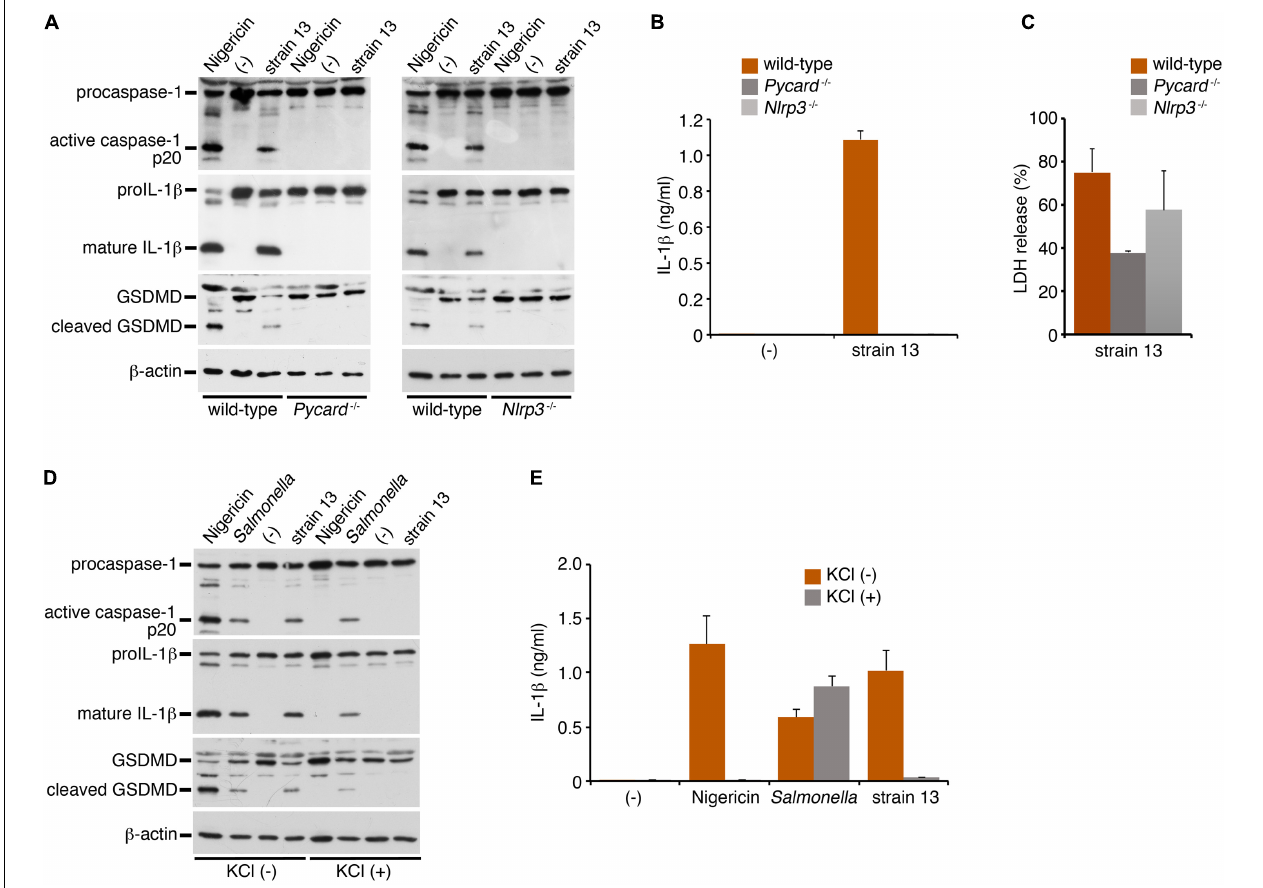
FIGURE 3 | Clostridium perfringens triggers inflammasome activation through the NLRP3-ASC axis. BMDMs from wild-type, NLRP3- ( Nlrp3 − / − )- or ASC- ( Pycard − / − ) deficient mice were primed with LPS for 2 h and infected with WT C. perfringens (strain 13) for 1 h, or treated with 10 µ M nigericin for 30 min as positive controls (A,D,E) . The BMDMs were infected with C. perfringens , an SPI-2-deficient mutant of Salmonella for 1 h or treated with nigericin in the presence or absence of KCl (130 mM) (D,E) . (A,D) The activation of caspase-1, and cleavage of IL-1 β or GSDMD in the infected BMDMs were analyzed by immunoblotting with anti-caspase-1 (p20), anti-IL-1 β or anti-GSDMD antibody, respectively. (B,E) IL-1 β release from the infected BMDMs into the culture supernatants at 1 hpi was analyzed by an ELISA. Data are presented as the means ± SD of triplicate samples. (C) Culture supernatants of the infected BMDMs were analyzed for LDH release at 1